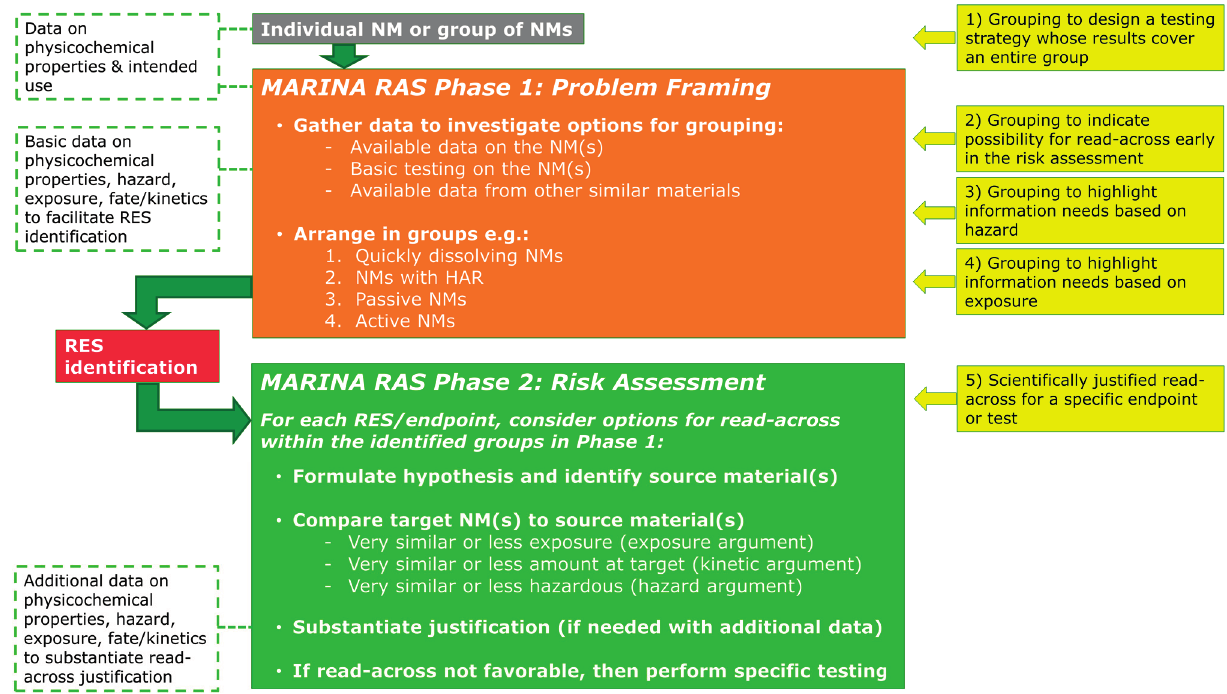
Figure 4. Possible applications of grouping and read-across of NMs (yellow boxes) in Phase 1 (orange box) and 2 (green box) of the MARINA Risk Assessment Strategy (RAS). These boxes are explained in more detail in the text in order of their numbering. The white boxes with green dotted outline represent input of data. HAR: High Aspect